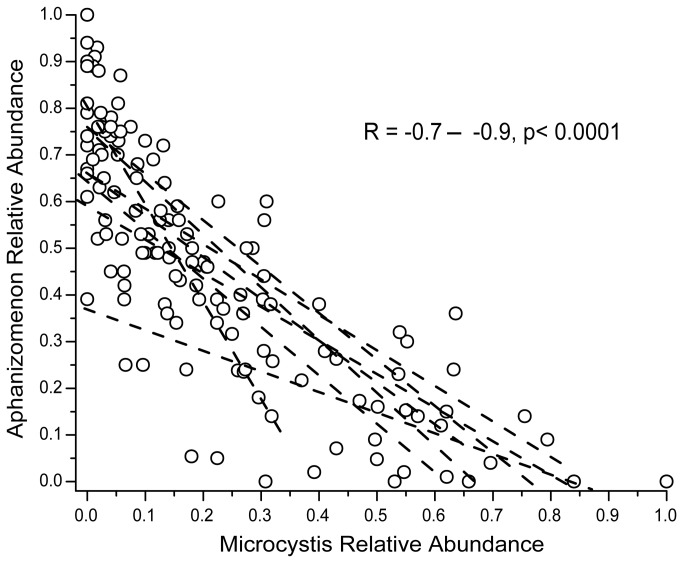
Significant negative linear relationships between 
Microcystis
 and 
Aphanizomenon
 relative abundance at nine of twelve sampling sites.The linear fit of the relationship at each of the nine sites is given by dotted lines.